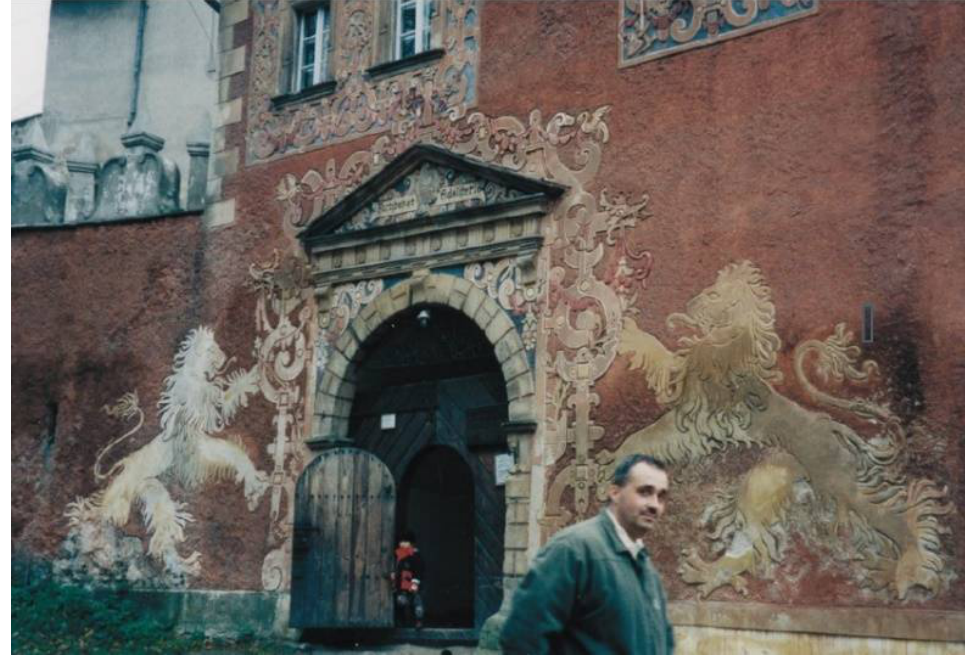
Figure 4. Decoration of the gatehouse at Grodno castle in Zagórze Śląskie. Author’s photo, 2003.